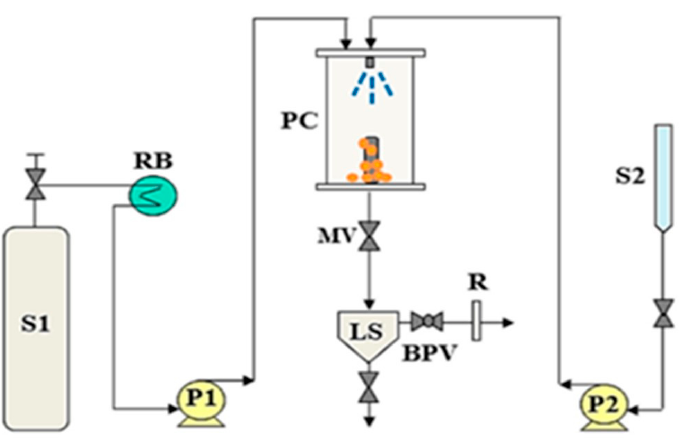
Figure 3. Schematic diagram of the supercritical antisolvent (SAS) apparatus, composed of: BPV: Back-pressure valve; LS: Liquid separator; MV: Micrometric valve; P1, P2: Pumps; PC: precipitation chamber; RB: Refrigeration bath; S1: CO 2 supply; S2: Liquid solution supply; R: Rotameter [22].